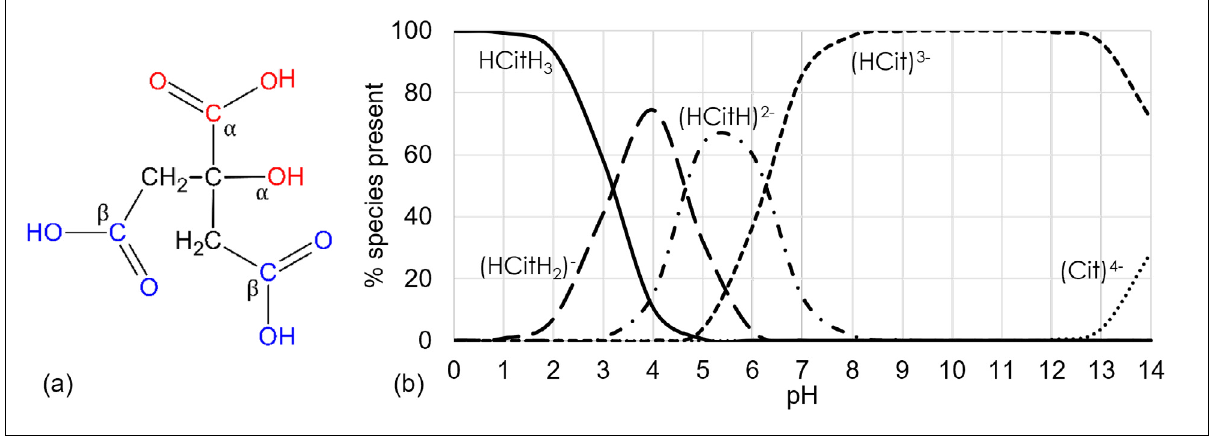
Figure 1: Citric acid (a) structure and (b) species distribution at 20 °C and I = 0.1